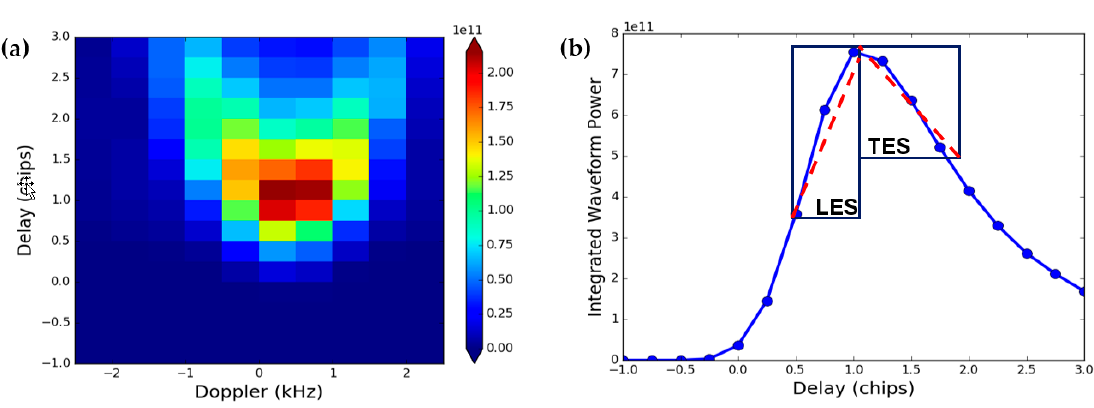
Figure 5. ( a ) Example of a bistatic radar cross section Delay Doppler map (DDM); ( b ) integrated delay waveform (IDW) derived from ( a ). The leading edge slope (LES) is estimated from the peak in the IDW and the two preceding points, while trailing edge slope (TES) is derived from the IDW peak and three following points.